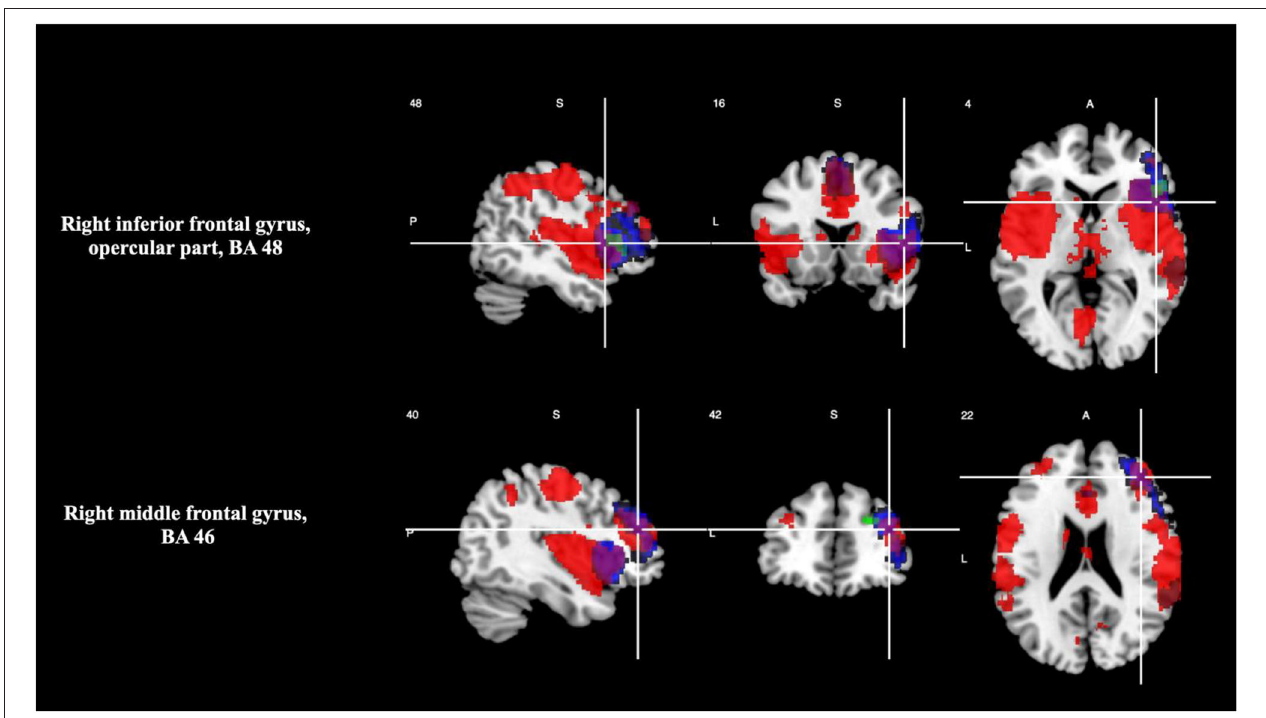
FIGURE 3 | Overlap between brain regions engaged during timing and oddball tasks (magenta). Brain regions in neurological convention showing areas with statistically signification activation only during timing tasks (green) and during oddball tasks (red).